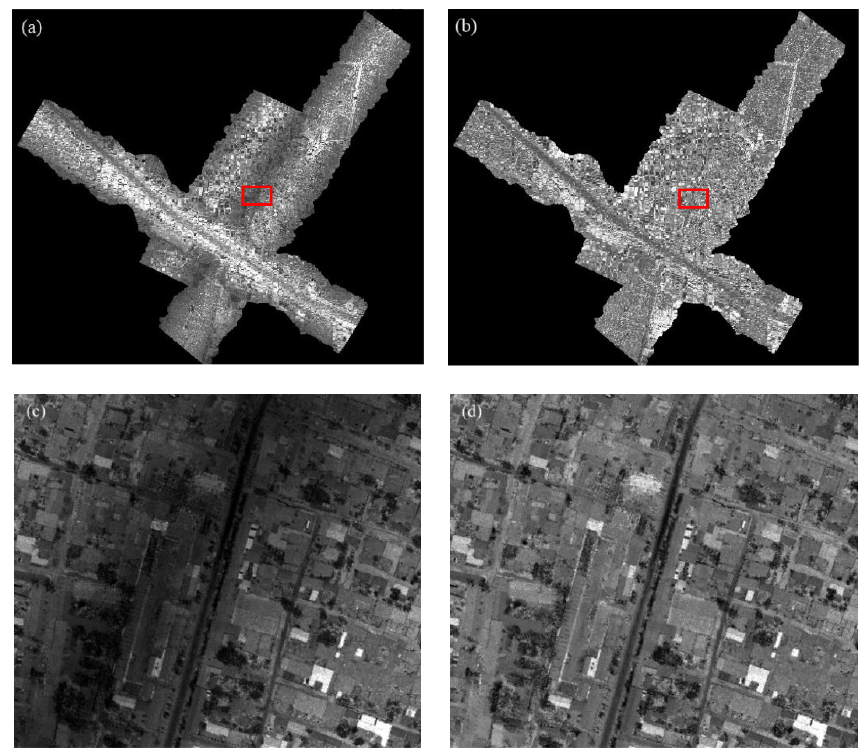
Figure 6. ( a ) The original intensity data (the amplitude); ( b ) the corrected intensity data by eliminating the effects of incident angle and range; ( c ) details of the red box in ( a ); ( d ) details of the red box in ( b ).